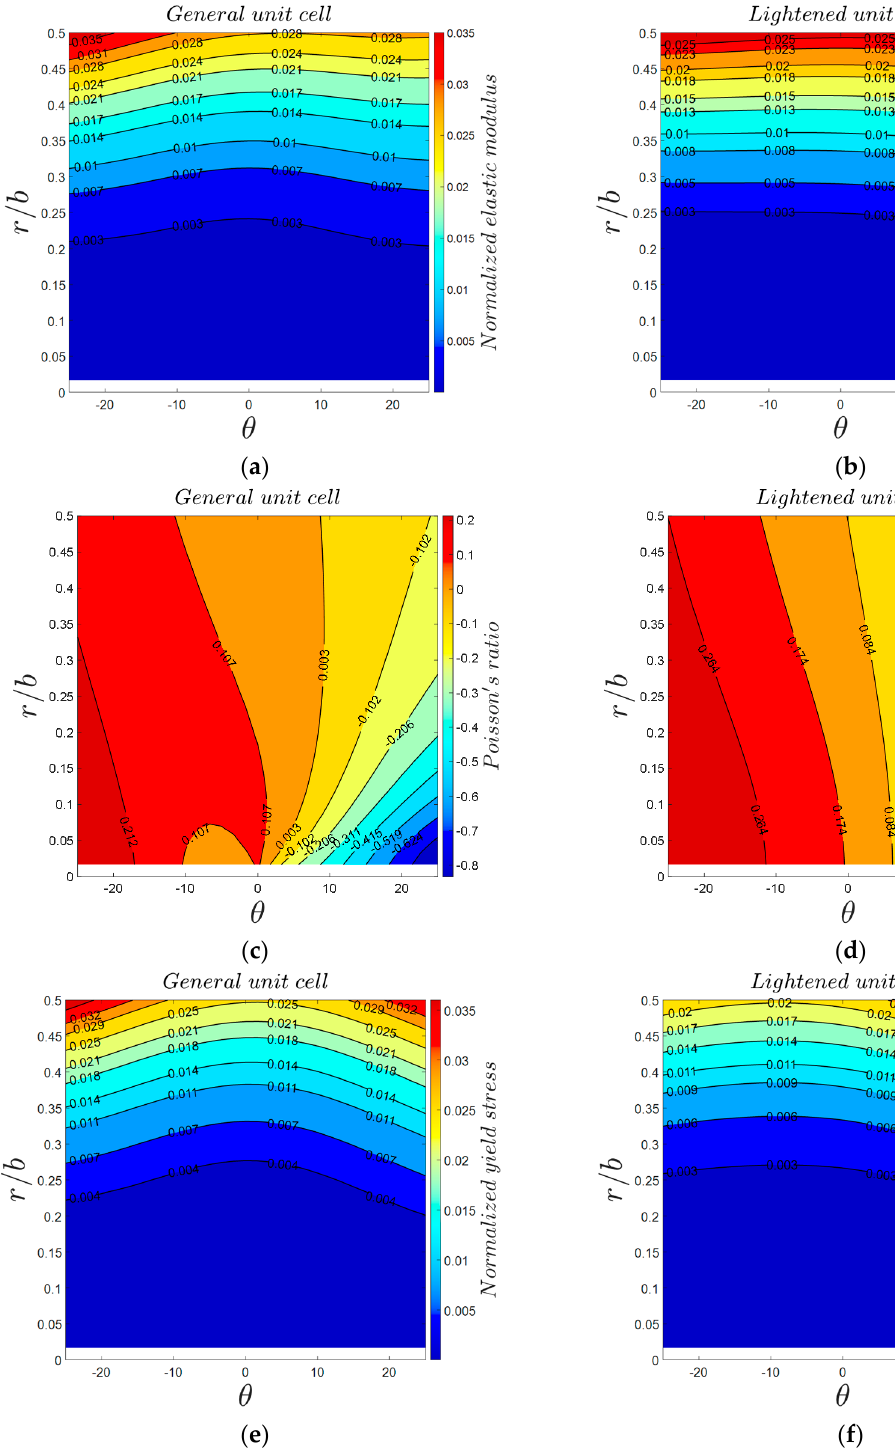
Figure 17. Contour plots of mechanical properties of general (left) and lightened (right) unit cells with respect to r / b and θ parameters: ( a , b ) normalized elastic modulus, ( c , d ) Poisson’s ratio, and ( e , f ) normalized yield stress.